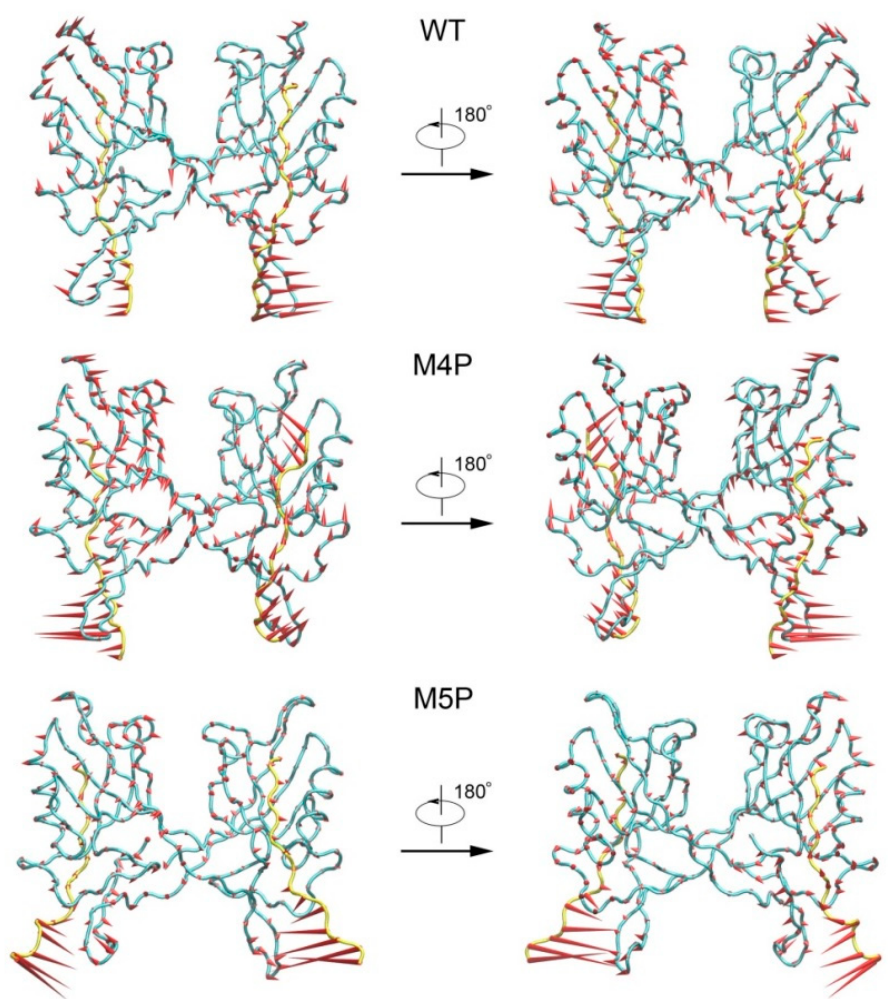
Figure 5. First slowest motion modes of WT, M4P and M5P systems. The protein C α atoms are represented by tube model. Shank3 N-PDZ is colored in cyan and SAPAP E-PBM peptides are colored in yellow. The length of the cone is correlated positively with motion magnitude, and the orientation of the cone describes the motion direction.